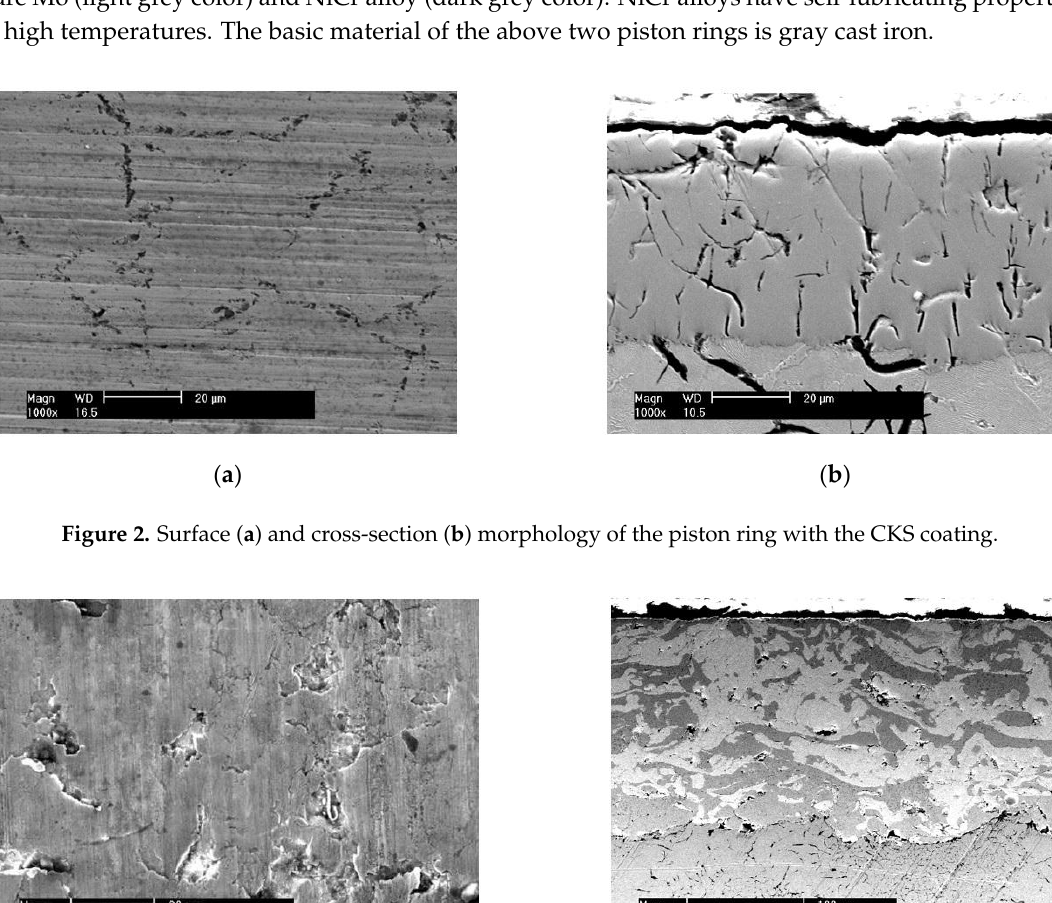
Figure 1. Piston ring reciprocating cylinder liner test rig.